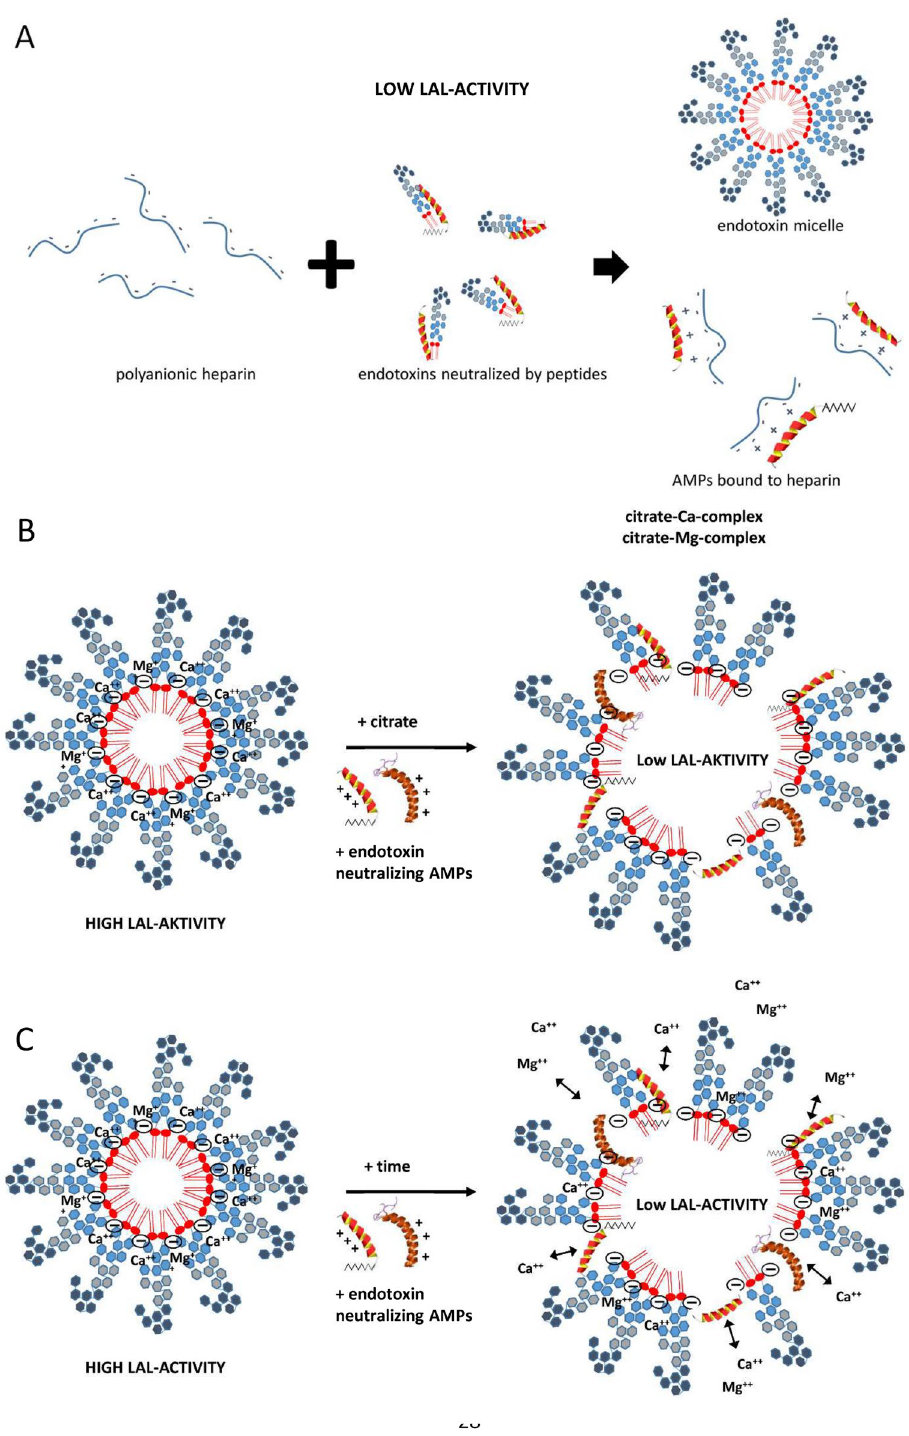
Figure 17. Schematic representation of endotoxin neutralization by plasmatic AMPs and its influence by anticoagulation. The polyanionic heparin molecule binds the cationic AMP molecules by ionic interaction. The formation of a heparin-AMP complex overrides the endotoxin neutralization effect of some AMPs ( A ). The anticoagulant citrate binds divalent cations, which are responsible for the stabilization of the LPS micelles. This leads to a better and faster penetration of endotoxin binding and neutralizing substances to the active lipid A portion of the LPS monomer resulting in lower endotoxin recovery in the LAL test ( B ). Cationic antimicrobial peptides, can diffuse into the interior of the LPS micelles and displace the divalent cations there. This leads to a destabilization of the endotoxin micelles and to a neutralization of the endotoxin activity ( C